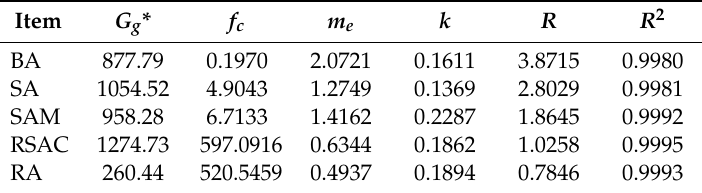
Table 6. The parameters of the CAM